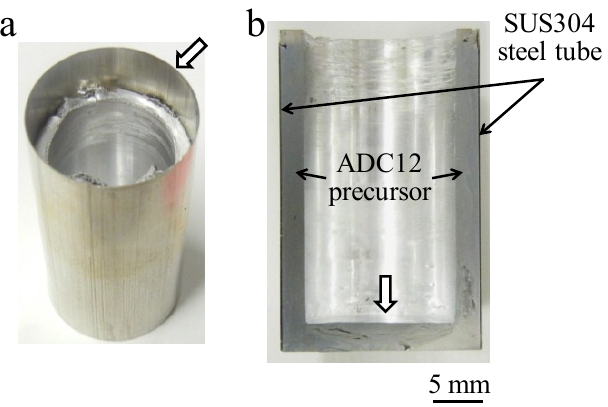
Figure 1. Fabricated precursor-coated steel tube: ( a ) Sample immediately after friction welding; ( b ) Cross-sectional image of ( a